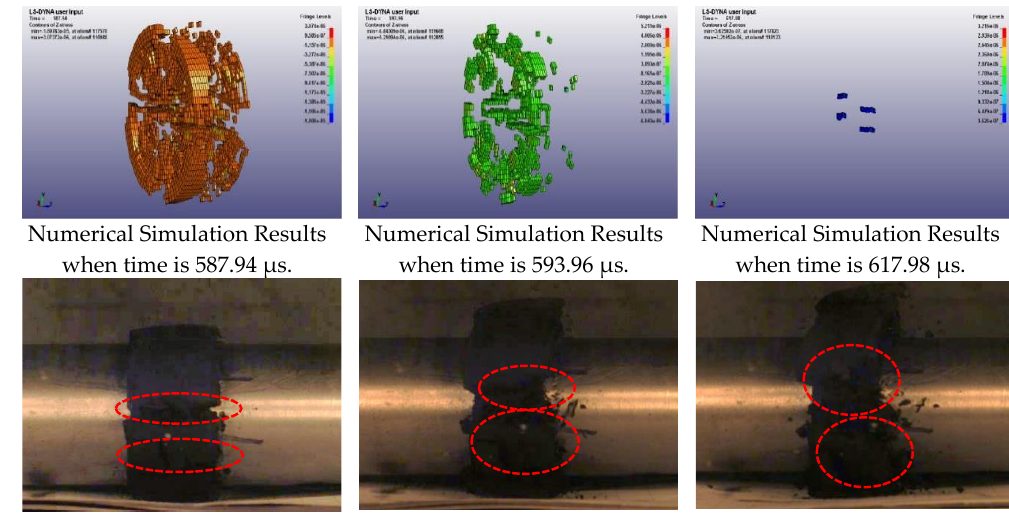
Figure 16. Dynamic change process of the impact failure of a coal body.